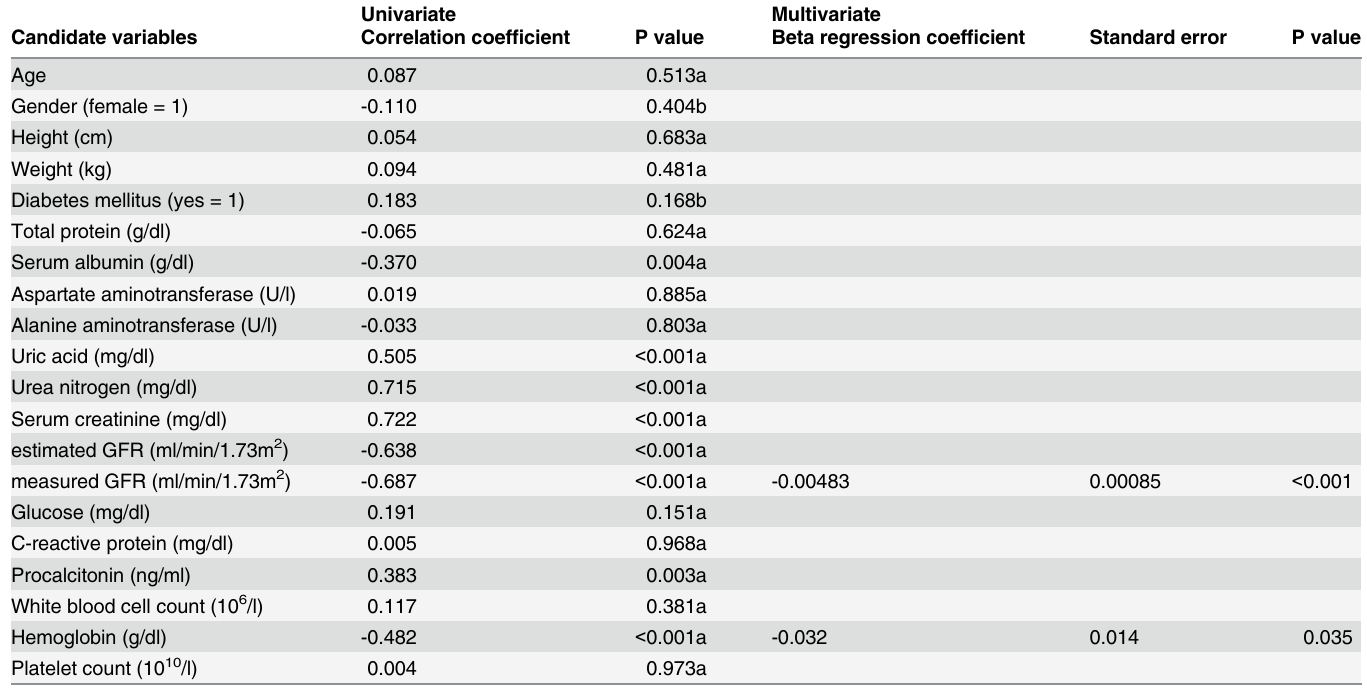
Table 2. Univariate analysis and multivariate linear regression analysis of the increase in log-transformed presepsin